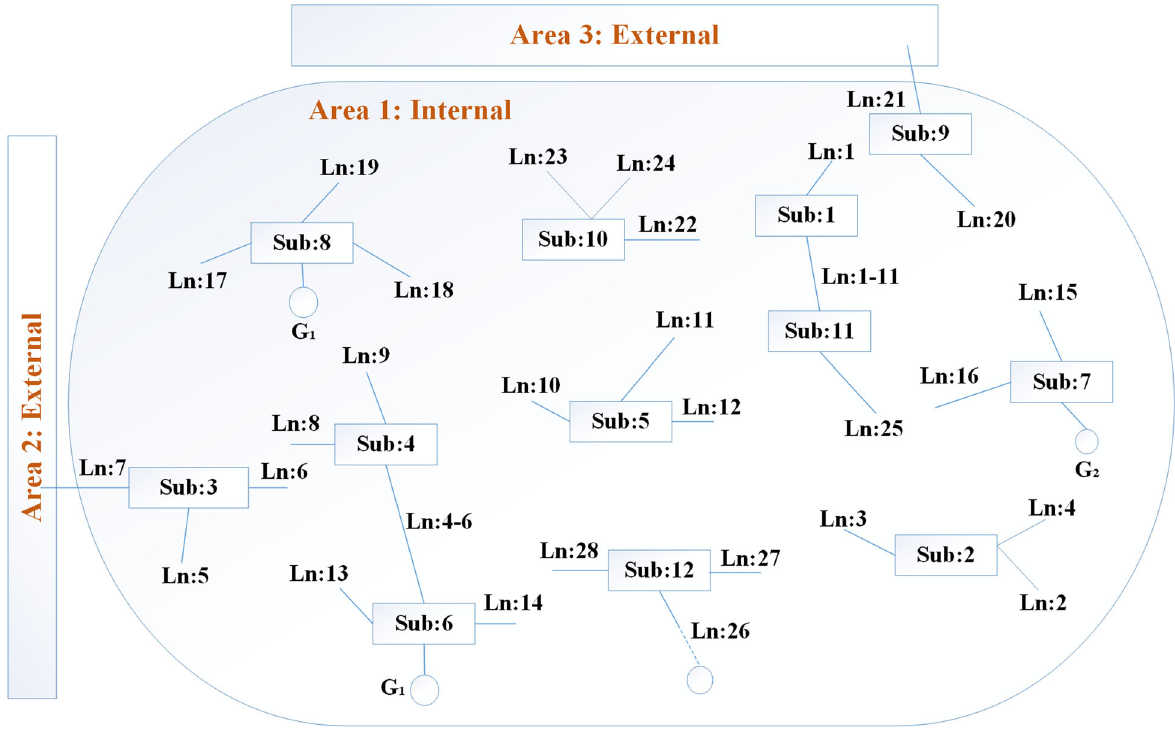
Fig. 9 Network Topology of ISO New England power system